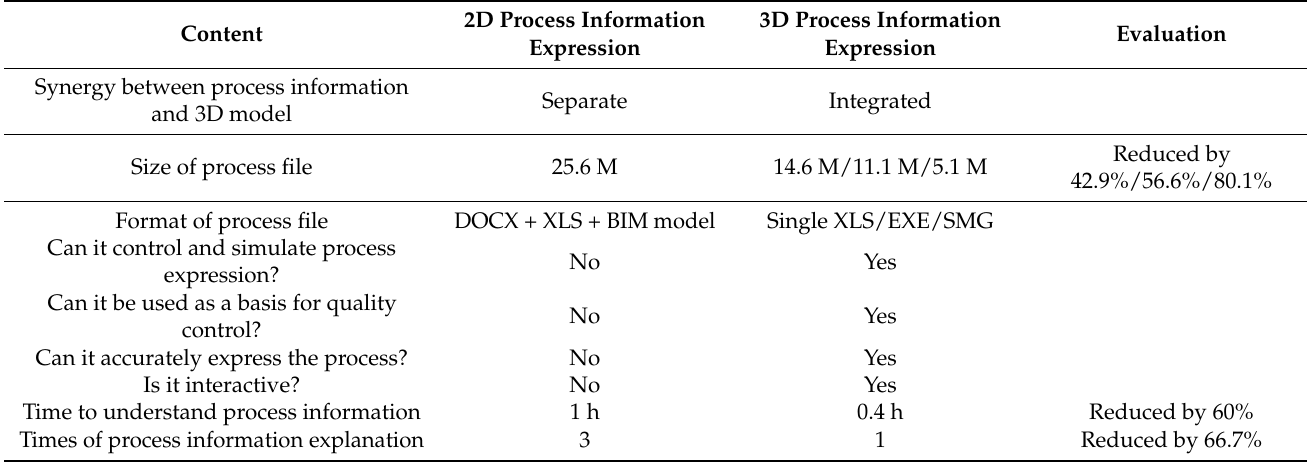
Table 3. Results of application